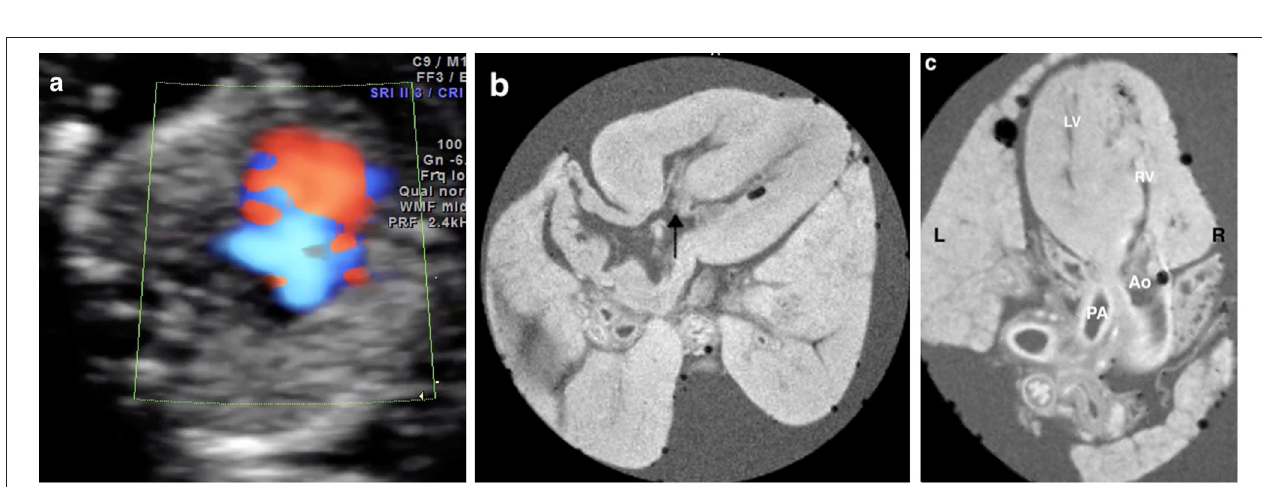
FIGURE 3 | Prenatal ultrasound, postmortem MRI, and microscopic evaluation in a fetus with hypoplastic left heart syndrome terminated at 15 + 5 weeks of gestation, showing the left ventricle was smaller than the right ventricle significantly and the arrows showed mitral valve atresia.